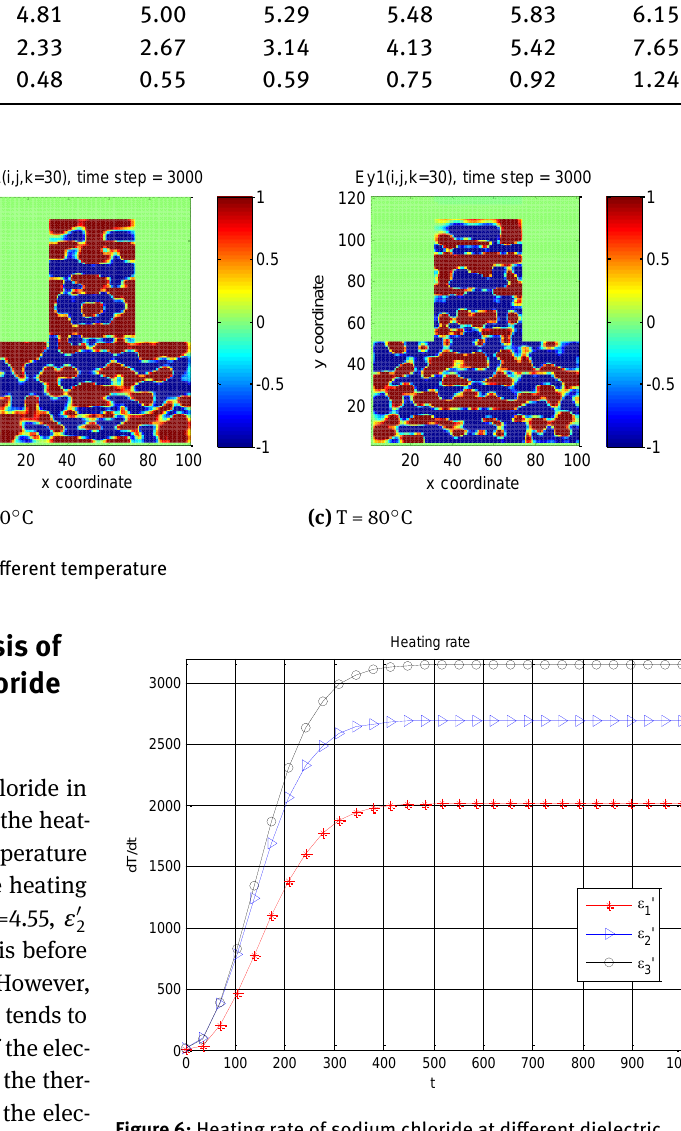
Figure 6: Heating rate of sodium chloride at different dielectric